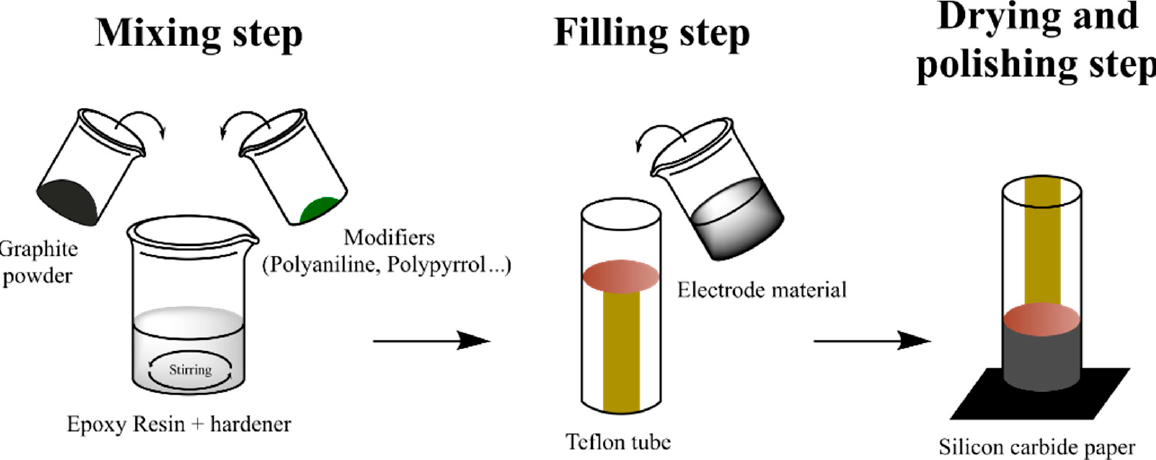
Figure 6. Fabrication of epoxy-resin electrodes modified with CPs powders.